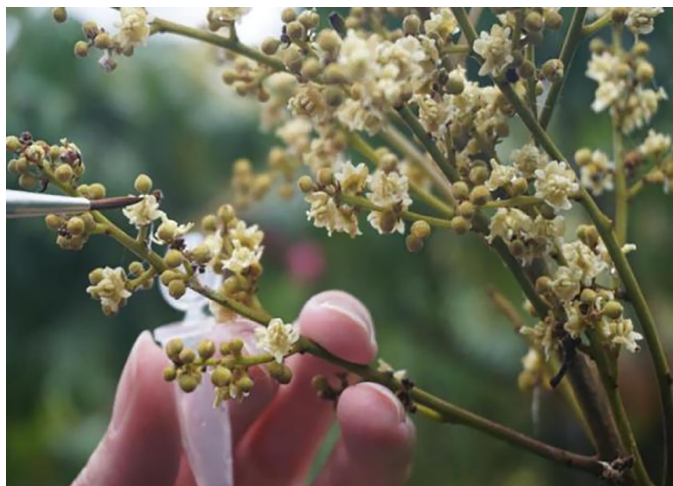
Figure 2. Artificial pollination with 2n pollen using a